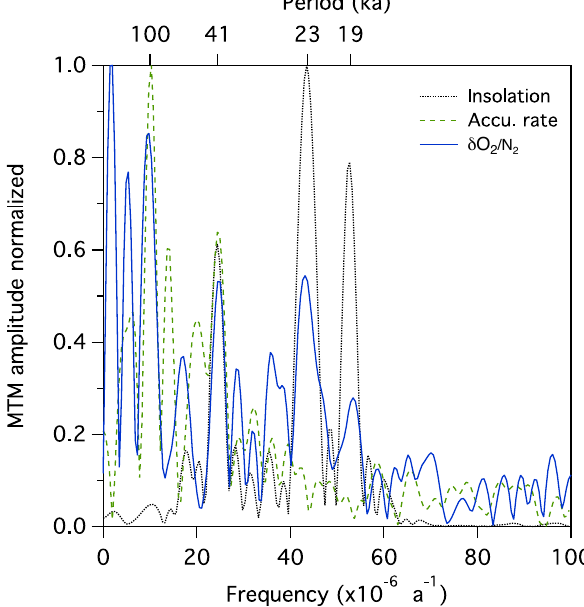
Figure 2. Spectral analysis using the multi-taper method with an interpolation step of 2ka for δ O 2 / N 2 between 340–800ka, obtained with Analyseries (Paillard et al., 1996). Amplitudes are normalized by the maximum value of each series. The δ O 2 / N 2 spectral analysis is presented in blue and compared with the spectral analyses of local summer solstice insolation (grey) and AICC2012 accumulation rate (dashed green). Periods corresponding to significant peaks ( F test > 90%) are indicated on the upper horizontal